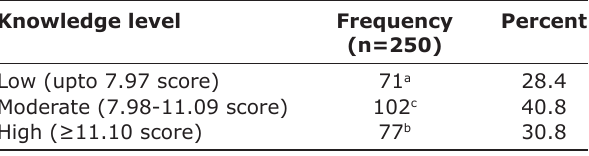
Table-2: Knowledge level of livestock farmers toward zoonotic diseases.